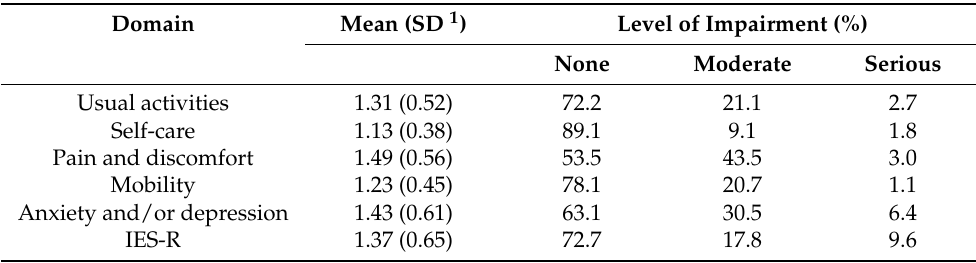
Table 3. Type and severity of traumatic events reported by TB patients using theEQ-5D-3L scale and IES-R ( n =